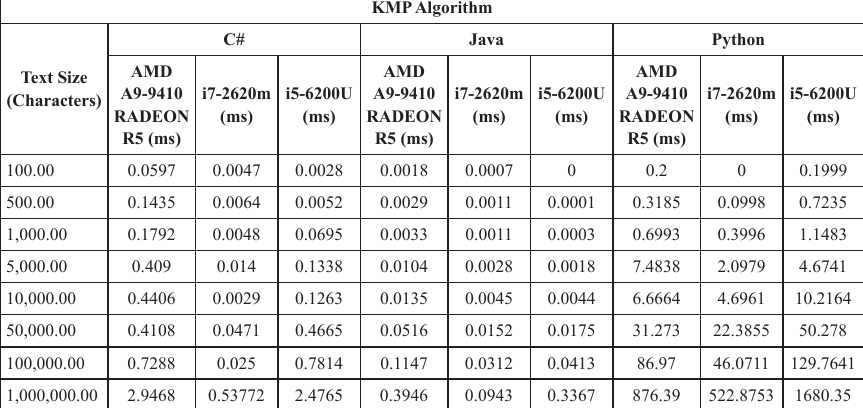
Table 2. Running time of KMP algorithm in C#, Java and Python programming languages KMP